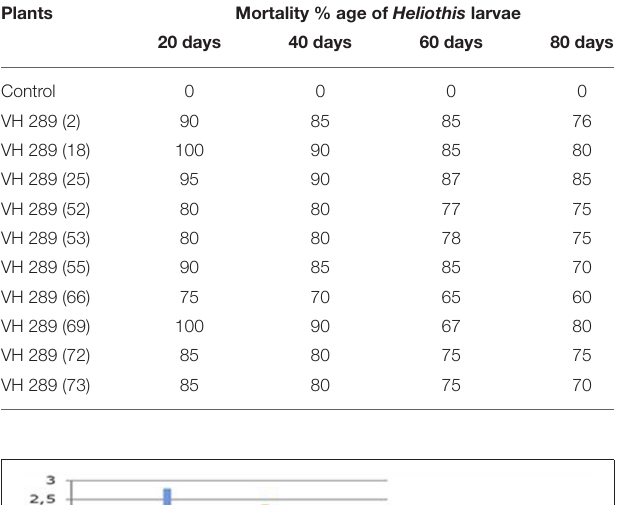
TABLE 6 | Tabulation of bio toxic leaf assay of transgenic cotton plant (T 0 Generation). Plants